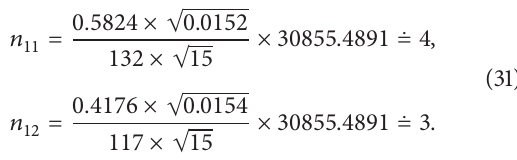
Table 2 summarized the 𝑛 21 , 𝑛 22 , 𝑛 11 , and 𝑛 12 in the